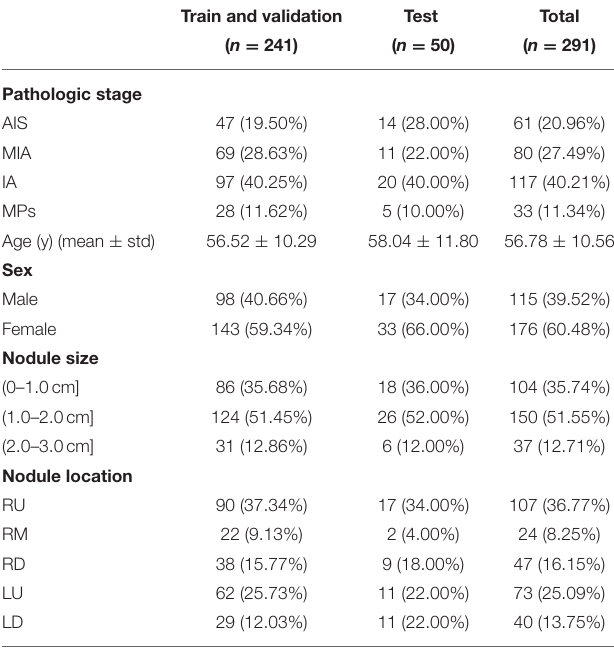
TABLE 1 | The baseline of the patients included in the